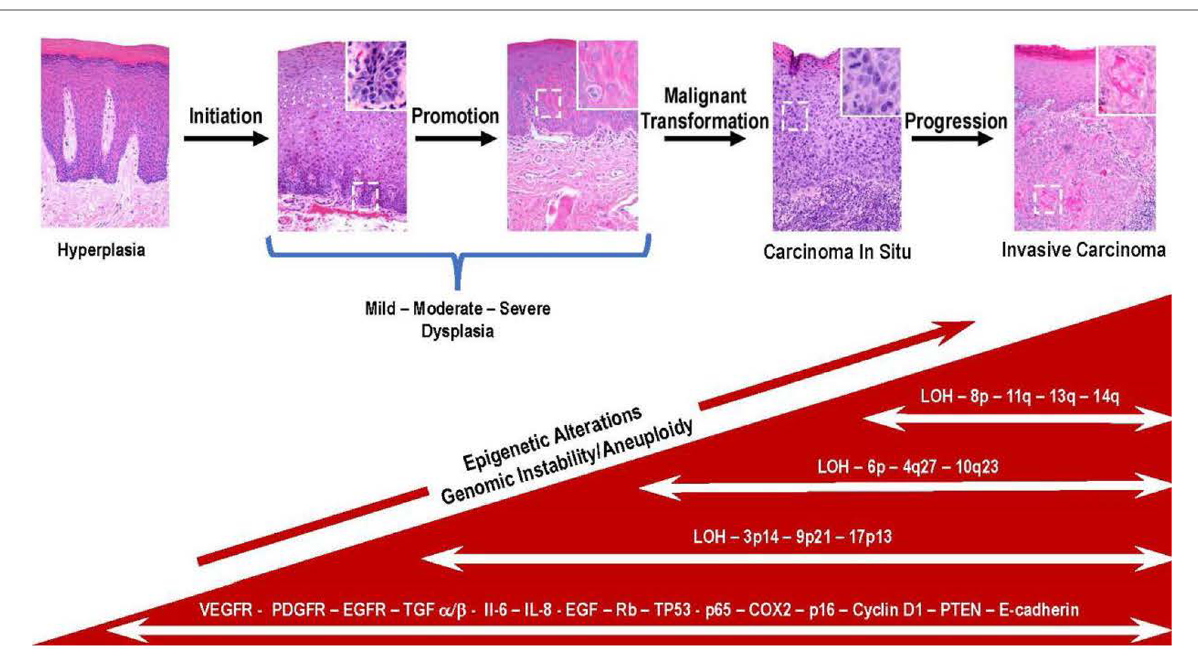
FIGURE 1 Key genetic and molecular events during the progression of premalignant oral epithelium to oral squamous cell carcinoma are depicted in this multistep model of histologic progression. The histological sequence of events seen in the progression of premalignant epithelium is initiated in the basal cell layer following exposure of stem cells to carcinogens. This results in irreversible damage and or epigenetic modi fi cation of DNA resulting in the emergence of a population of cancer stem cells. The subsequent exposure to promoting agents contribute to the clonal expansion of initiated cancer stem cells. With the continued exposure to promoting agents, a subset of initiated stem cells undergoes malignant conversion (i.e., carcinoma in situ ). Over time cancer stem cells and bulk tumor cells acquire additional mutations many which involve loss or inactivation of tumor suppressor genes (TP53, PTEN, LOH) and overexpression of molecular mediators (Il-6, IL-8, VEGFR, PDGF). The bidirectional exchange of information between cancer and host cells contribute to acquisition of more aggressive phenotypes by the invading cancer cells (100X magni fi cation, inset, white boarder,